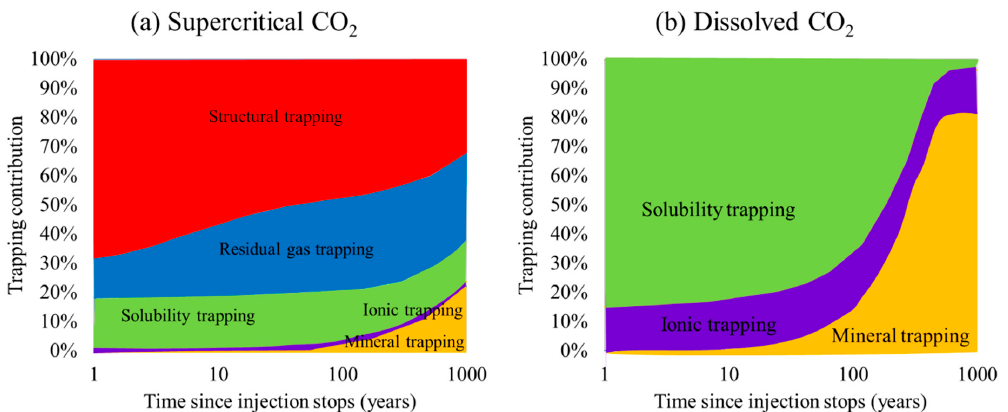
Figure 17. Comparison of the contributions of the different trapping mechanisms between the two scenarios.